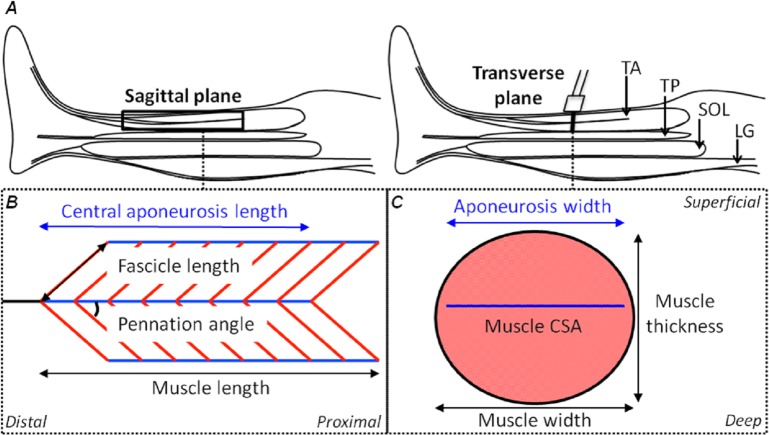
Schematic representations of the shank in the sagittal plane and the tibialis anterior muscle in the sagittal and transverse planes with its geometrical parameters defined.(A) A sagittal plane representation of the shank with the tibialis anterior (TA), tibialis posterior (TP), soleus (SOL) and lateral gastrocnemius (LG) muscles identified. (B) A sagittal plane representation of the TA muscle showing its bi-pennate architecture with the superficial and deep muscle fascicles (oblique red lines) at an angle to the aponeuroses (horizontal blue lines) with the free tendon (horizontal black line) in-series with the central aponeurosis. Measures of central aponeurosis length, fascicle length, pennation angle and muscle length have been defined in the sagittal plane. (C) A transverse plane representation of the TA muscle showing its central aponeurosis (horizontal blue line) separating the superficial and deep muscle compartments. The ultrasound transducer in (A) identifies the slice location. Measures of central aponeurosis width, muscle thickness and muscle width have been defined in (C) and the shaded salmon area shows muscle cross-sectional area (CSA).